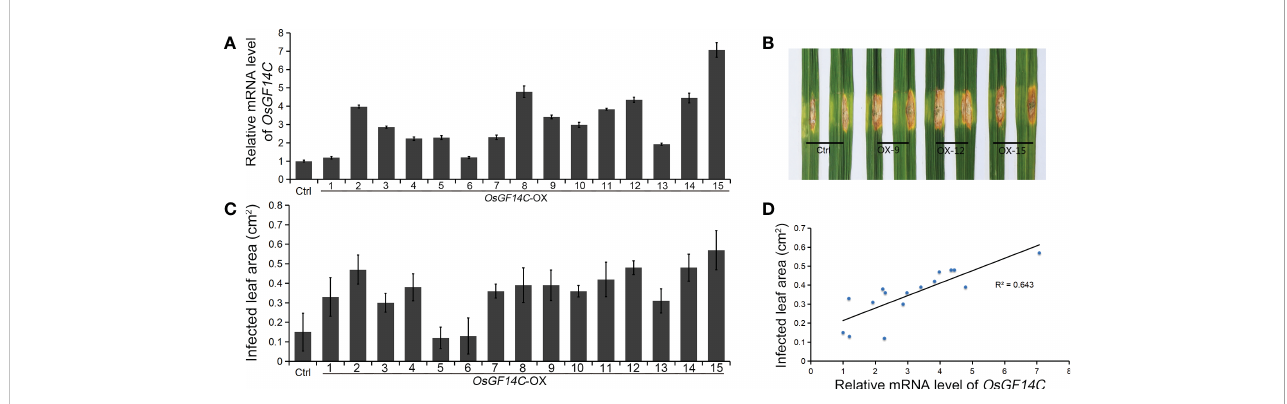
FIGURE 3 The role of OsGF14C in resistance to blast stress in rice. (A) , the relative OsGF14C transcription of independent 15 OsGF14C -OX lines; (B) , the infected lesions areas of Ctrl and OsGF14C -OX lines after inoculation using punch method; (C) , the infected lesions areas on leaves of the 15 OsGF14C -OX lines; (D) , the correlation between (A, C) .